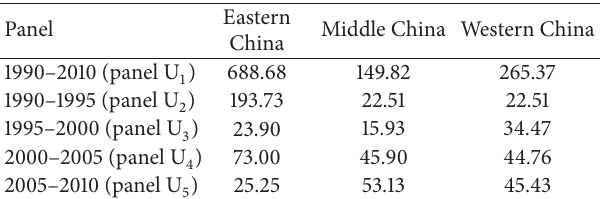
Table 2: Urban expansion rate of Eastern China, Middle China, and Western China (%). Eastern Panel